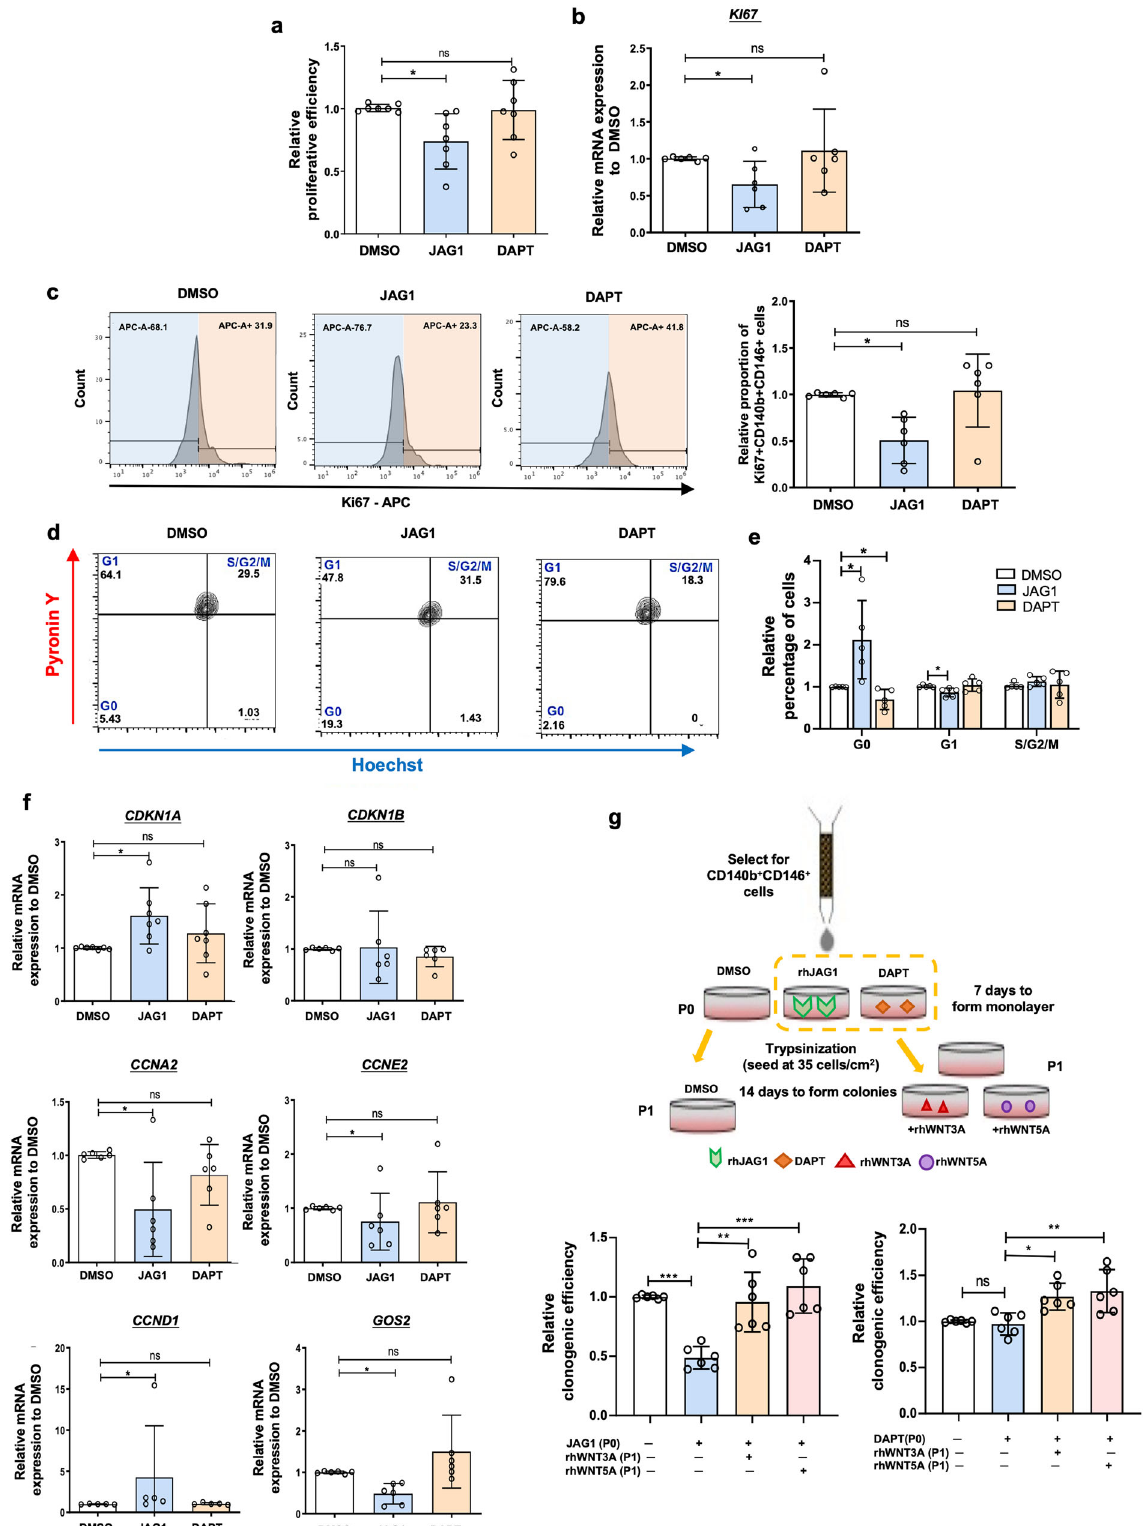
Interaction of Notch and WNT/ β -catenin pathway in eMSC Action of Notch activity on active β -catenin . Crosstalk between the Wnt and the Notch pathway has been reported in different systems 21 . Our above results indicated that the JAG1-induced quiescent eMSC could be reactivated by Wnt activation, suggesting a crosstalk between these two signaling pathways. Therefore, we